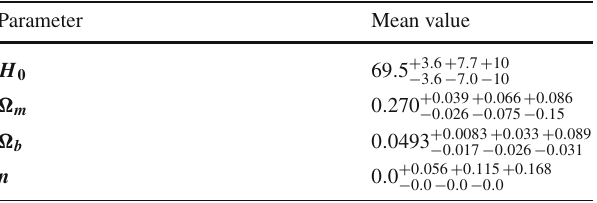
Table 1 Case I: Mean value of the parameters H 0 ( kms − 1 Mpc − 1 ) , (cid:7) (cid:7) m , b and n from Fig. 2 and 68%, 95% and 99% c.l.